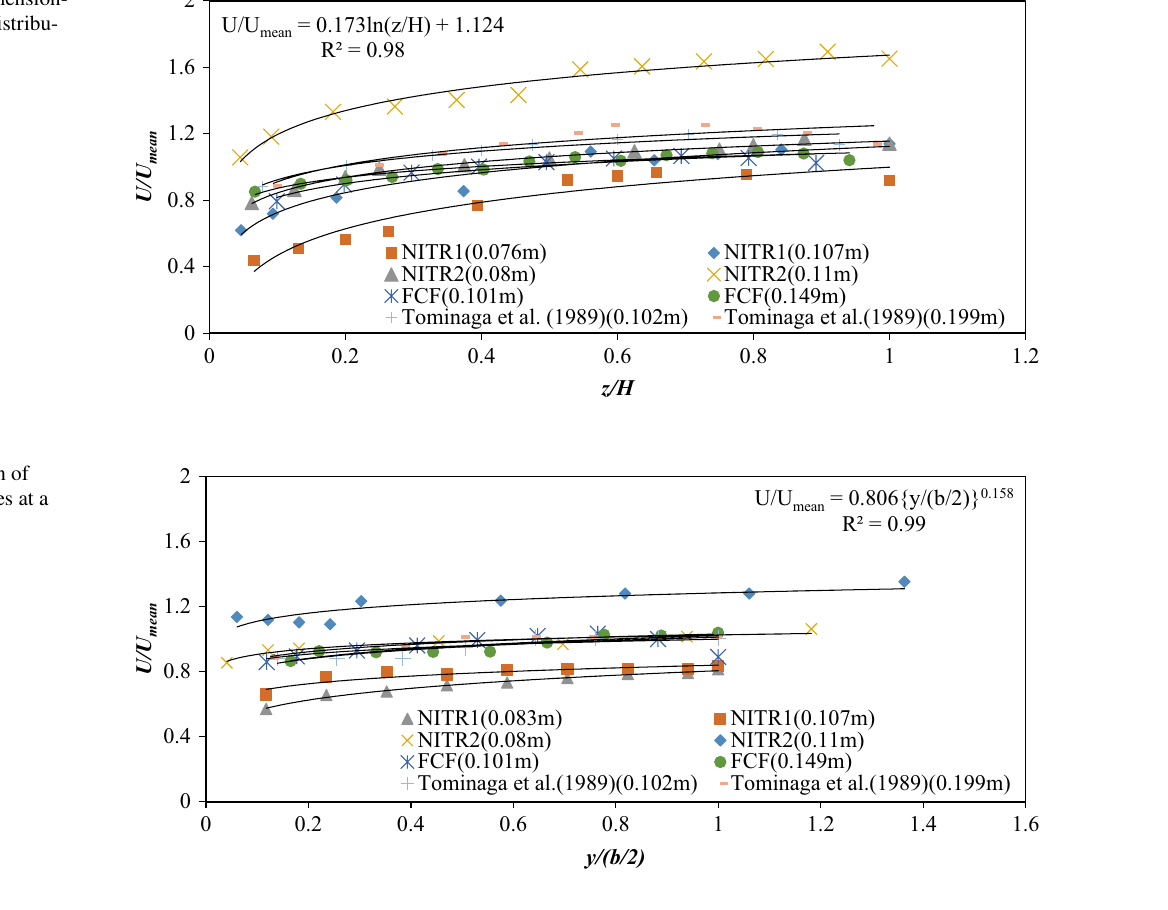
Fig. 3 Variation of dimension- less vertical velocity distribu- tion